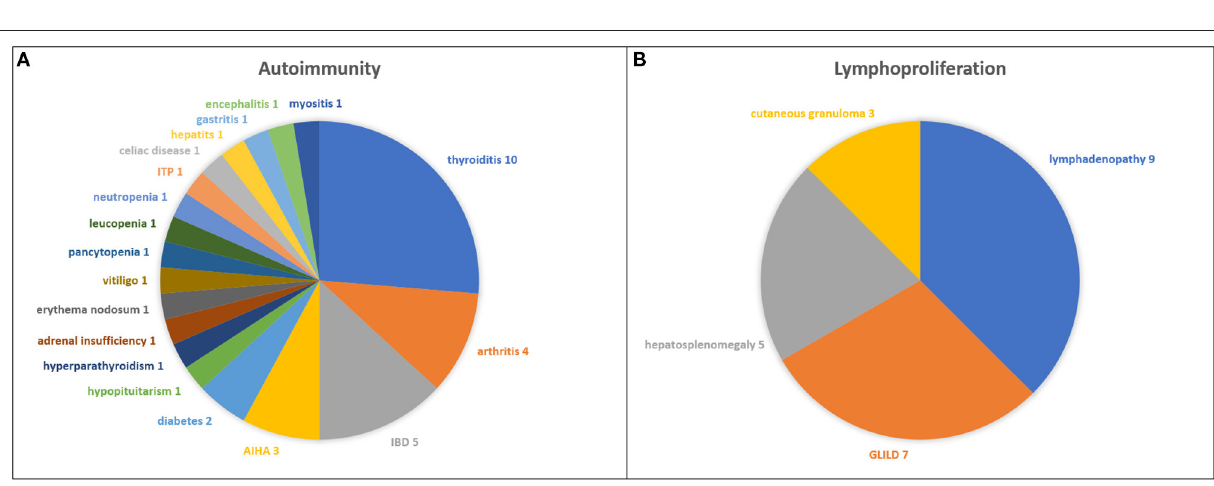
absolute Treg counts, this difference was statistically significant ( p =